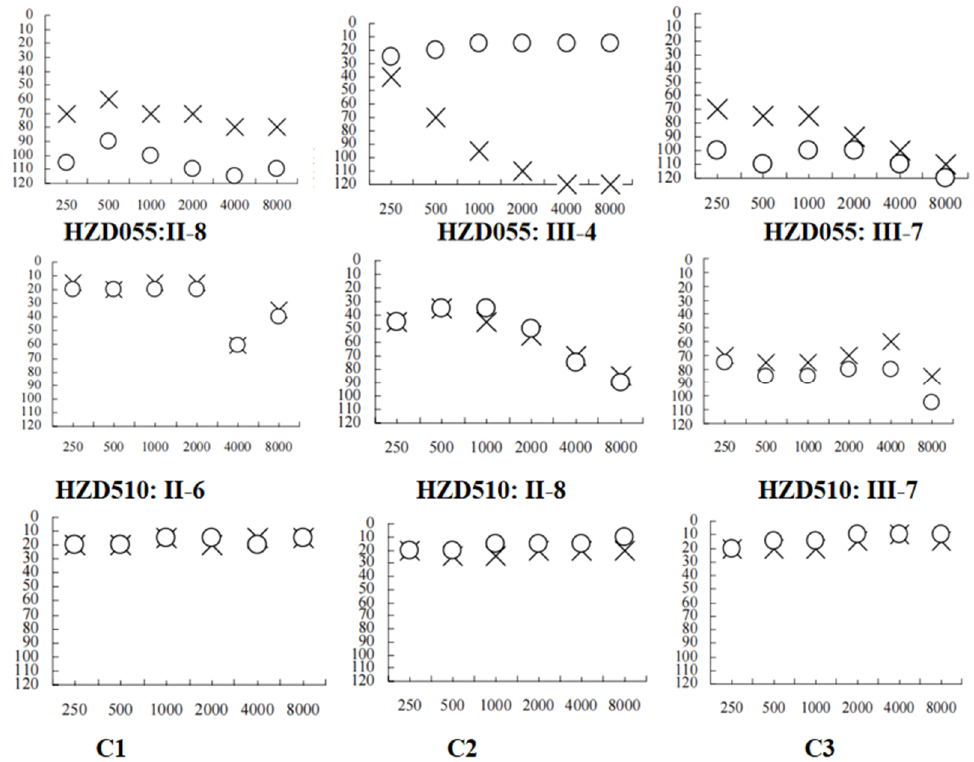
Figure 2. Audiograms of several matrilineal relatives in two Chinese families with AINSHL. X: left ear; O: right ear; C1: HZD055: II-6; C2: HZD055: III-1; C3: HZD055: III-3.